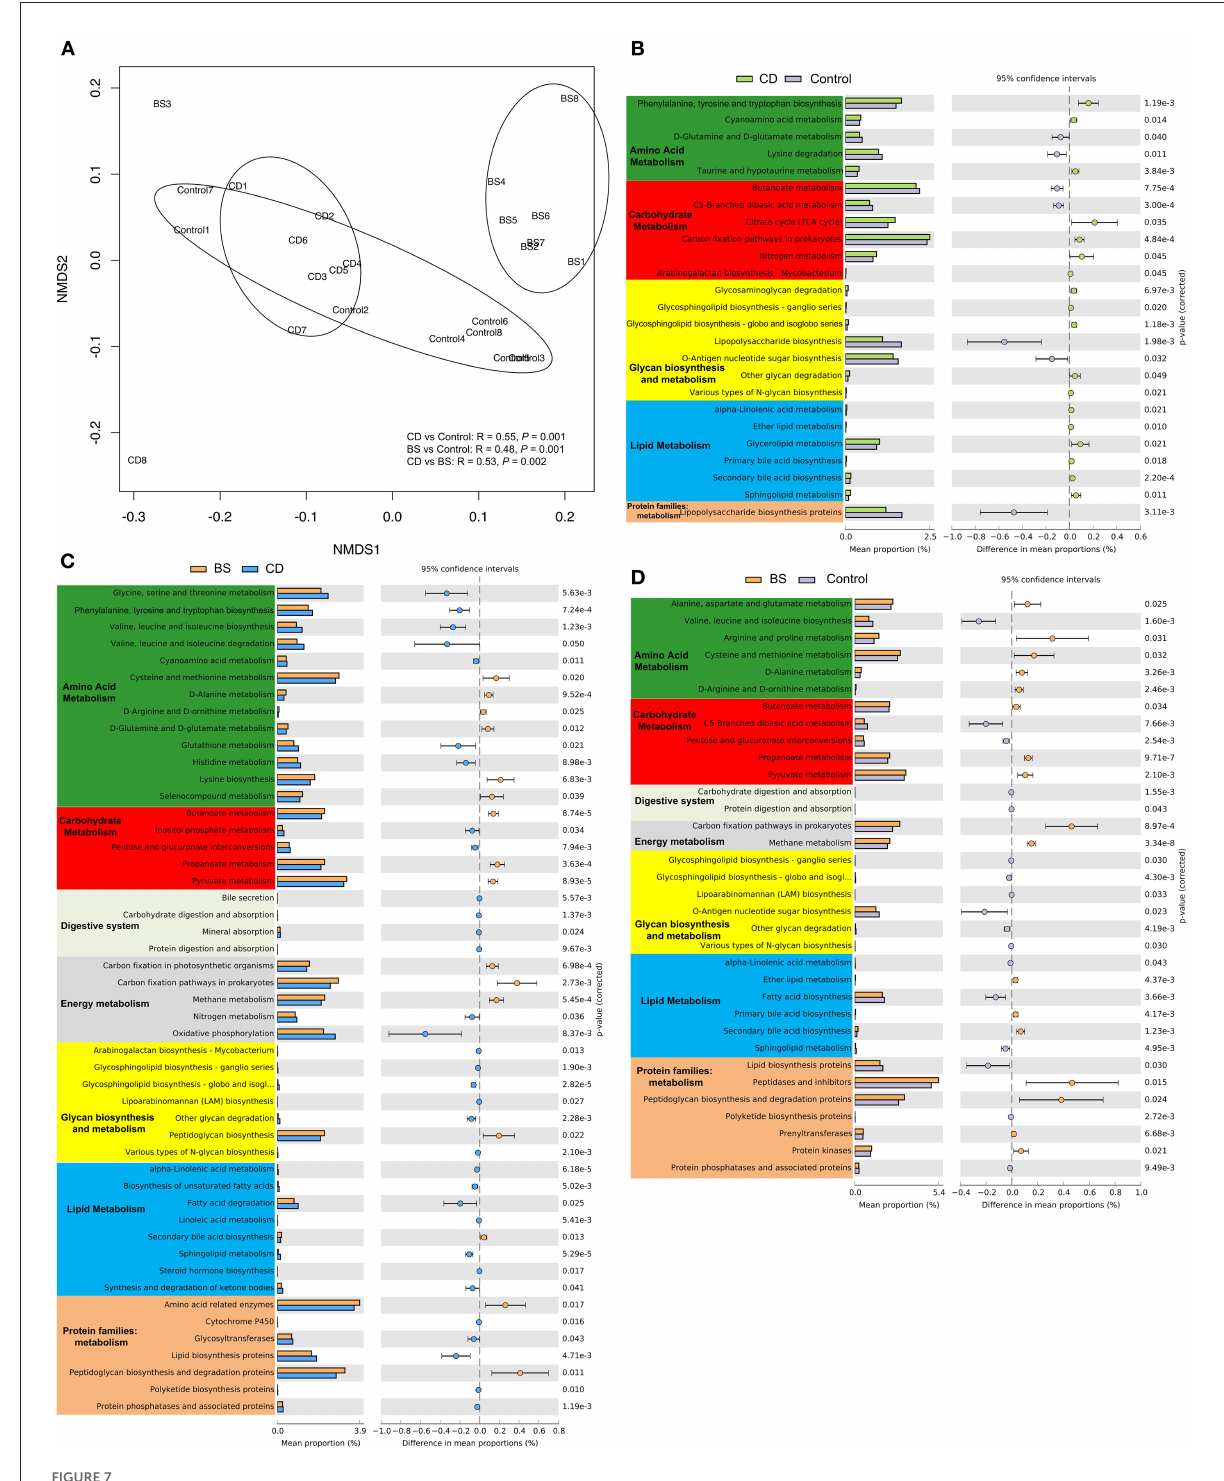
FIGURE7 Non-metric multidimensional scaling (NMDS) plot visualizing bacterial functional community dissimilarities using Bray-Curtis distance (A) . Differentially abundant KEGG pathways between CD and Control (B) , BS and CD (C) , or BS and Control (D) groups by